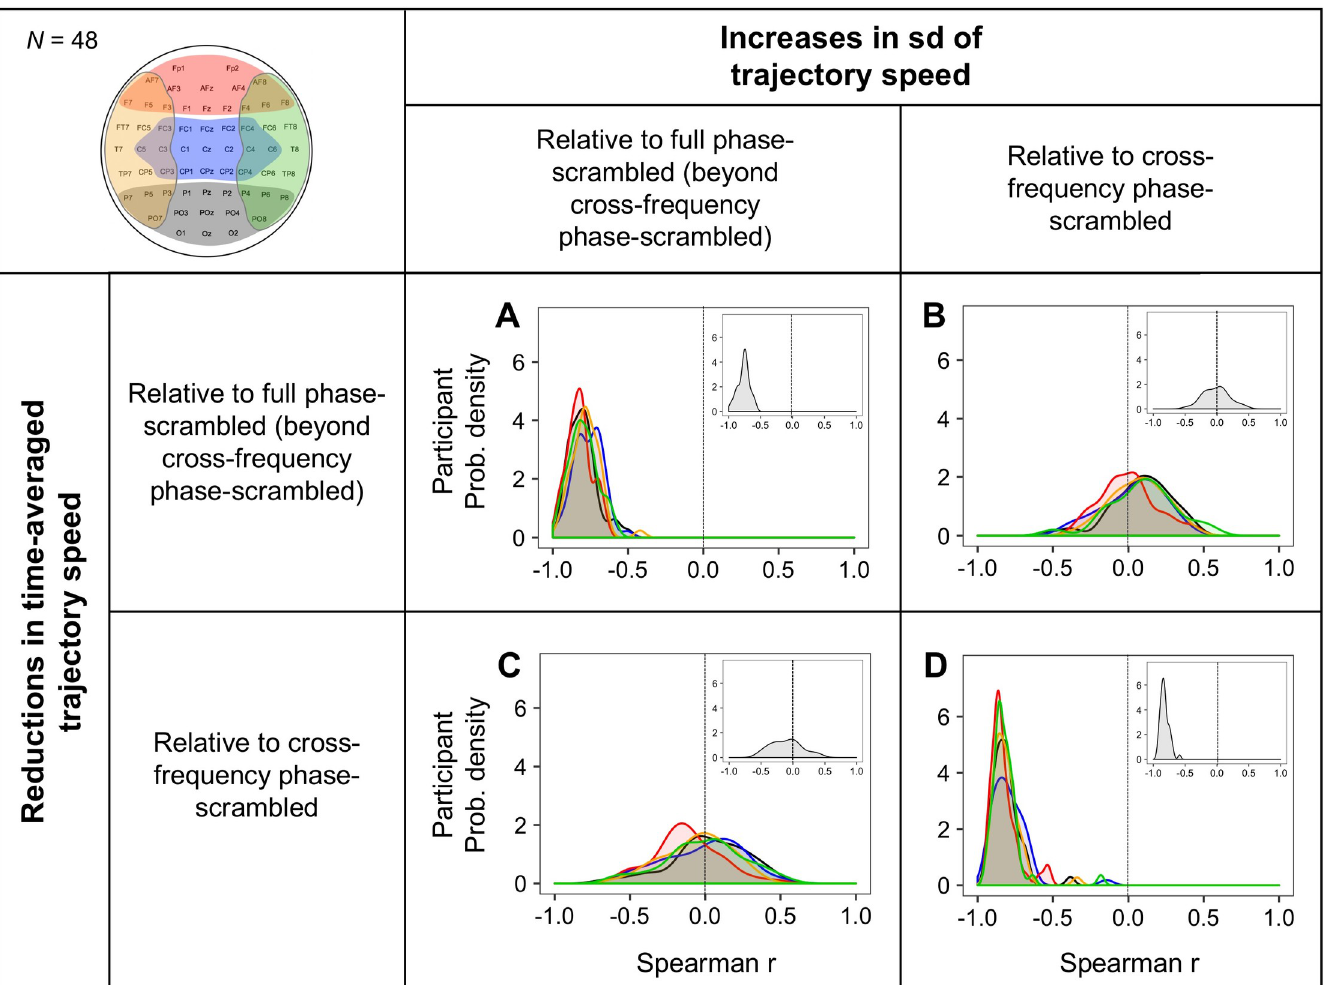
Fig 8. Temporal associations (across 5-sec time segments) between reductions in time-averaged trajectory speed and increases in its standard deviation (sd). Each variable was measured relative to the full phase-scrambled controls (beyond the cross-frequency phase-scrambled controls) to reflect the effects of cross-site within- frequency phase relations, and relative to the cross-frequency phase-scrambled controls to reflect the effects of cross-frequency phase relations. Temporal associations are organized in a 2-by-2 design where the two hypothetical underlying mechanisms, the coordination of cross-site within-frequency phase relations and the coordination of cross-frequency phase relations, are matched on the diagonal ( A and D ) and crossed on the off diagonal ( B and C ). Each panel shows the cross- participant distributions (as interpolated probability density functions) of Spearman r values for the five regions (posterior: black, central: blue, anterior: red, left-lateral: orange, and right-lateral: green). The insets show the corresponding distributions for EEG-state trajectories for the global non-adjacent site configuration (see Fig 10).